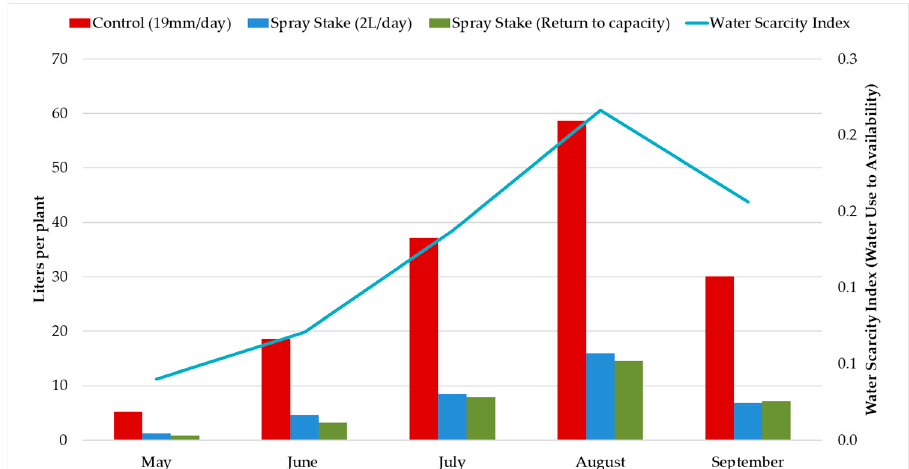
Figure 1. Monthly water scarcity footprint of irrigation water applied (WSF iwa ) of selected woody plant grown in 10.2 L containers for data collected in May through September 2017, under four irrigation regimens in a model research nursery in Michigan. The right y-axis shows the Water Scarcity Index using the Water Use to Availability (WTA) method [39].